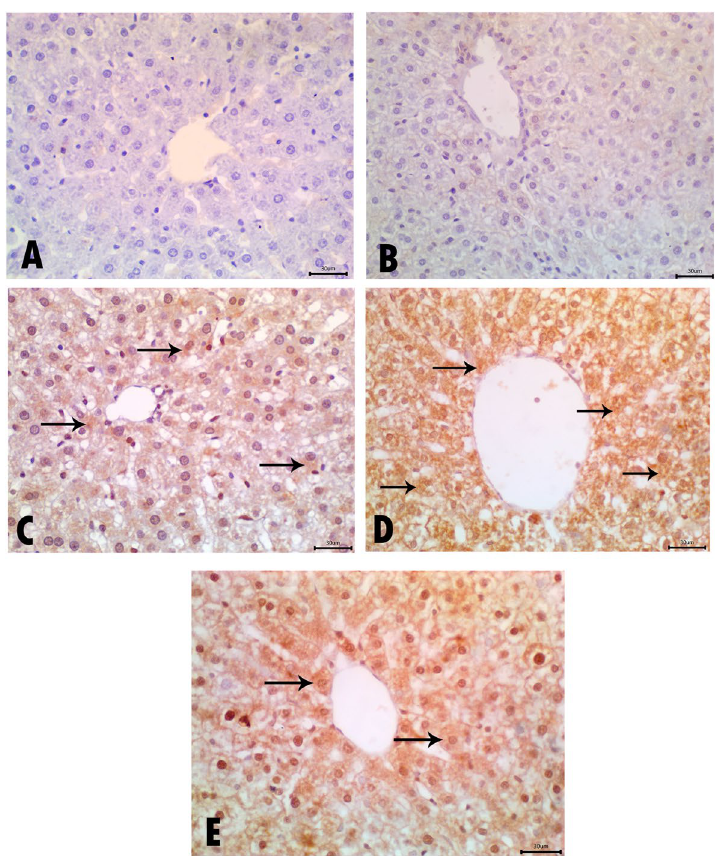
Fig. 10 Photomicrographs of sections in the liver immunohistochemically stained with caspase-3 ( control groups show negative expression in the cytoplasm of hepatocytes. C The acute treated group shows positive immunoexpression in some hepatocytes (arrows). D Chronic treated group reveals positive cells with higher expression of caspase 3 in the cytoplasm of most of the hepatocytes (arrows). E Chronic withdrawal group shows the decreased caspase-3-positive expression in most hepatocytes